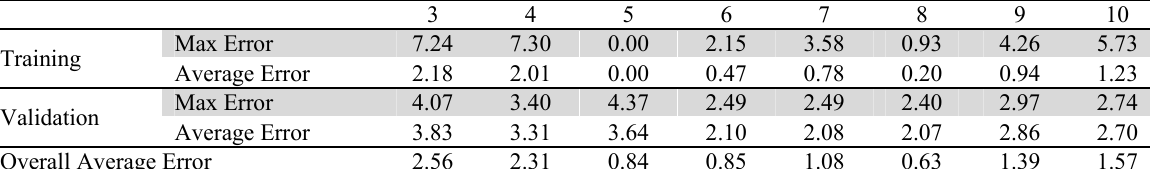
Maximum and average errors for Trial 3